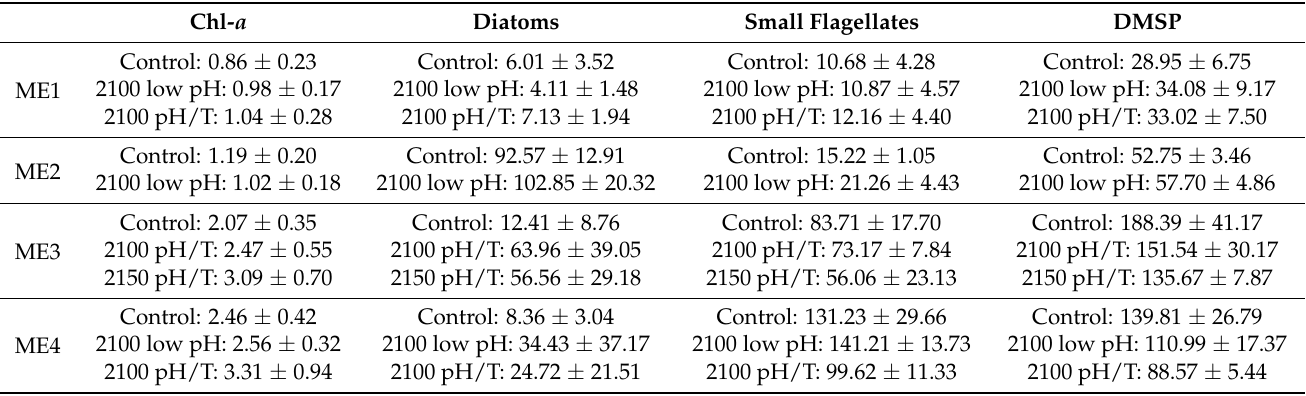
Table 3. Average per treatment during Phase 3 of Chl- a concentration in µ g L − 1 , diatoms and small flagellates carbon content in µ g L -1 and DMSP concentration in nmol L -1 in the different mesocosms with the associated standard